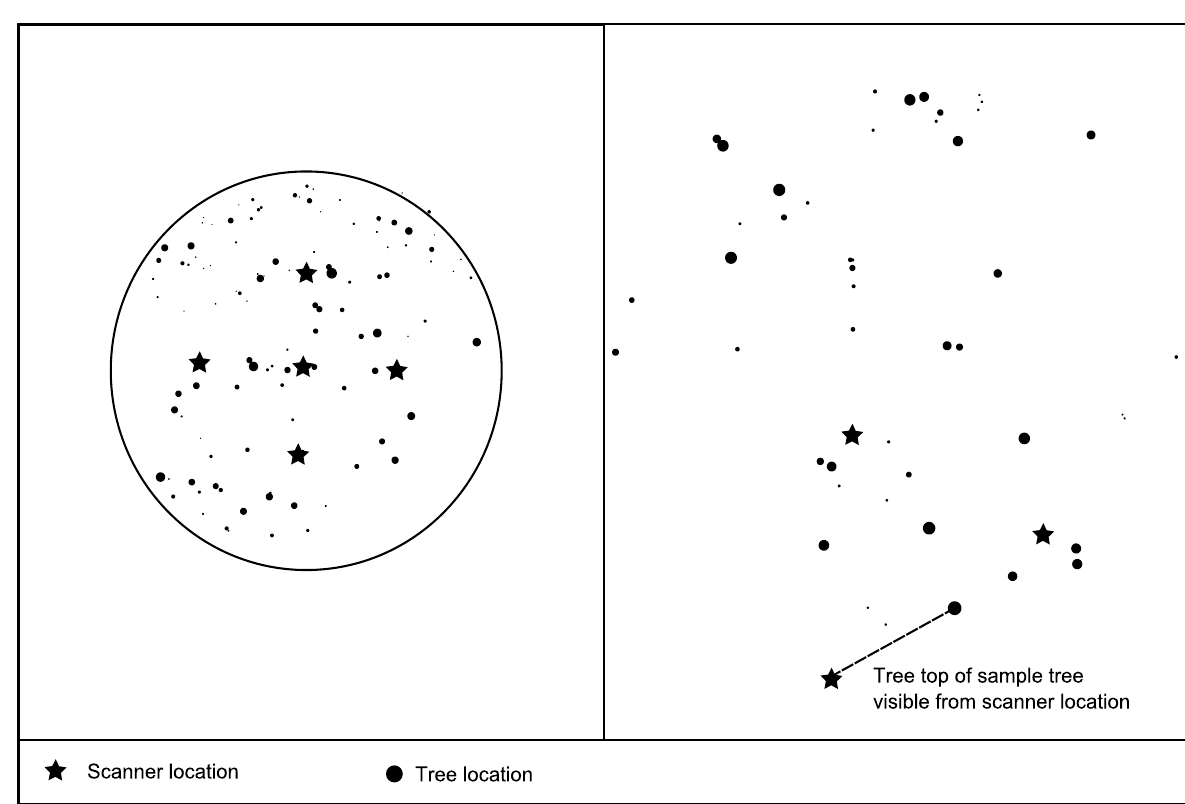
Figure 2. Example of scanner locations at the sample plots ( left ) and on locations with destructive sampled trees ( right